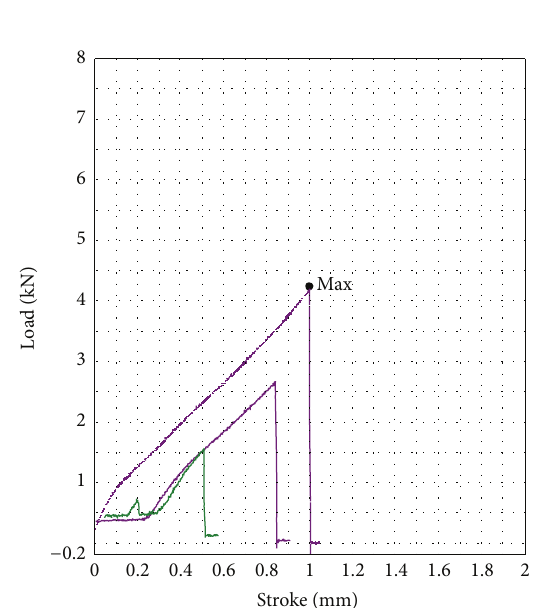
Figure 8: The curve of adhesive strength of as-sprayed